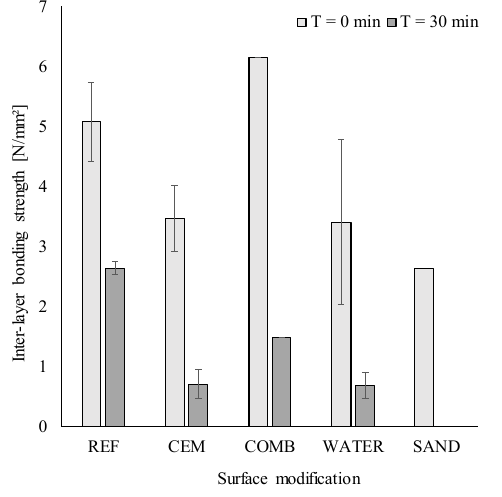
Figure 7. Inter‐layer bonding strength.